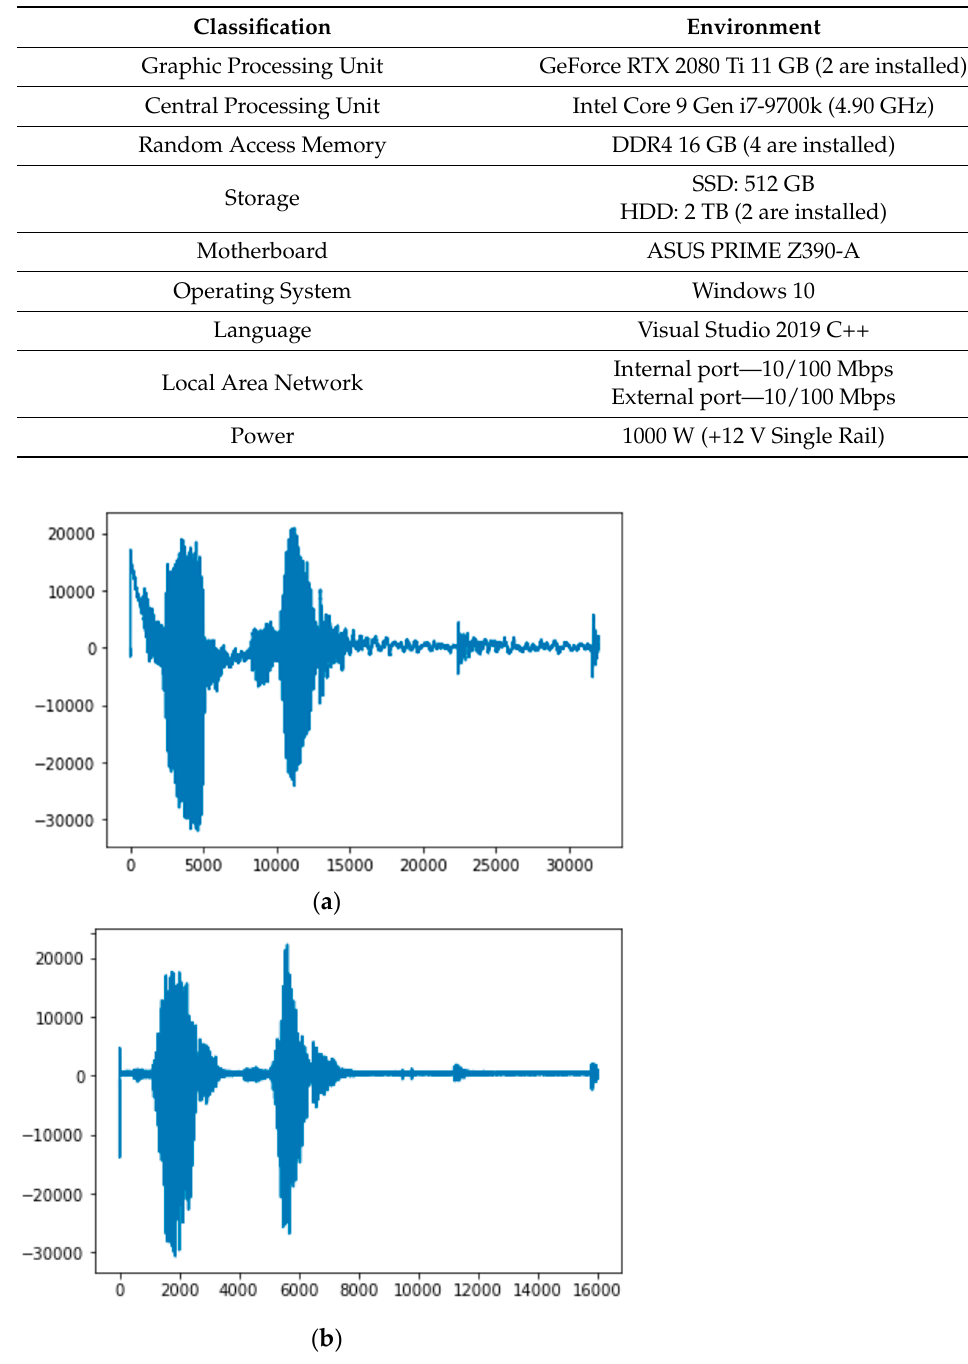
Figure 8. ( a ) Initial incoming signal and ( b ) appearance of signal after applying proposed algo-